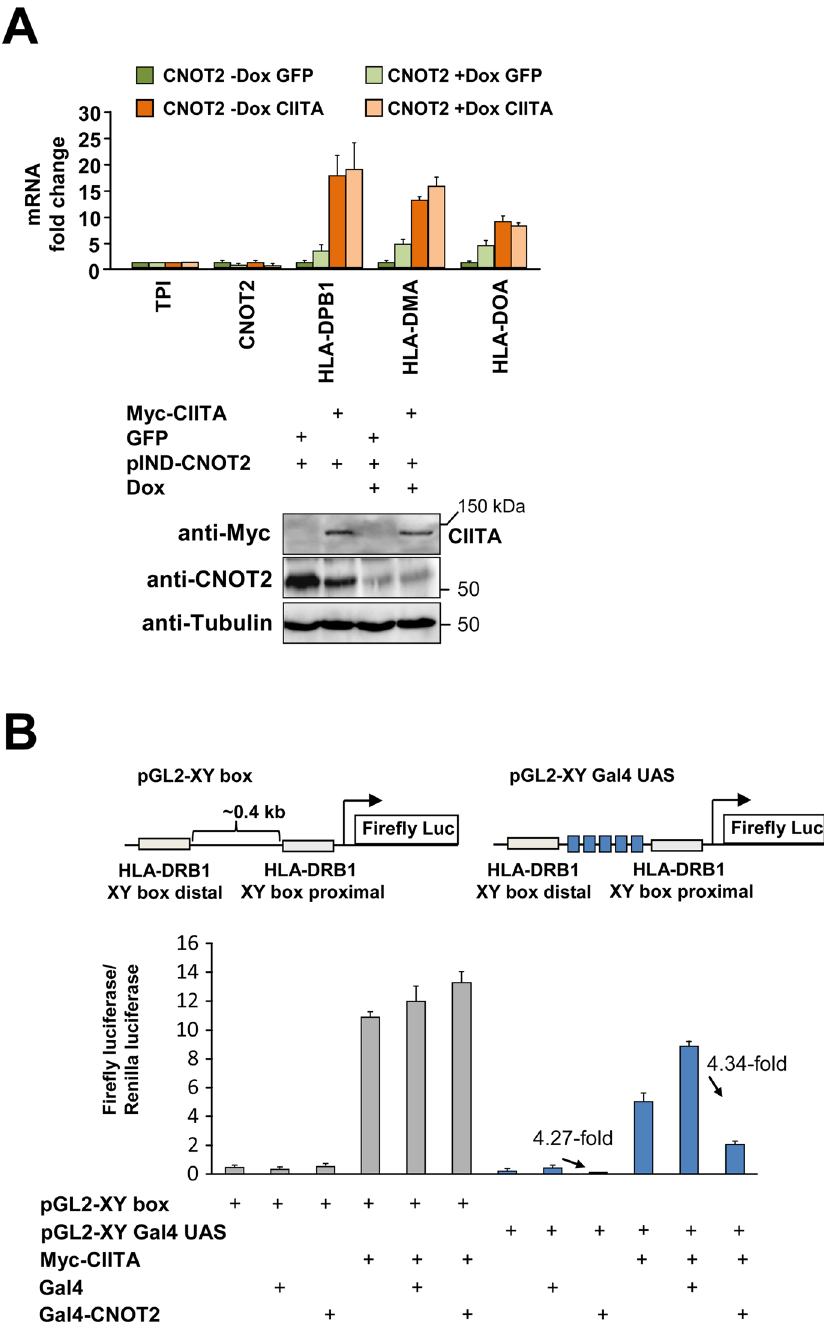
Figure 7. DNA tethering of CNOT2 mediates repression of MHC II transcription. ( A ) The HEK-293T cells with a stably integrated pIND CNOT2 plasmid were transfected to express either CIITA or as a control the GFP protein. Following Dox-mediated knock-down of CNOT2, one part of the cells was lysed for subsequent use by Western blot analysis (lower), while the other part was used to determine expression of endogenous MHC II genes by RT-qPCR. The error bars represent standard deviations from three biological replicates. ( B ) HEK- 293T cells were transfected with two different reporter constructs: One construct encompasses the proximal and distal XY boxes from the HLA-DRB1 promoter (left), while the other reporter construct contains additionally 5 binding sites for the yeast Gal4 protein (blue boxes at the right site). These different reporter genes were cotransfected with expression vectors for CIITA, Gal4-CNOT2 or the Gal4 control. The graph shows firefly luciferase activity obtained from transfected plasmids with the indicated constructs, normalized to the Renilla luciferase control. Fold repression achieved by CNOT2-Gal4 expression compared to Gal4 alone is indicated in the graph. Error bars represent the standard deviation from three biological